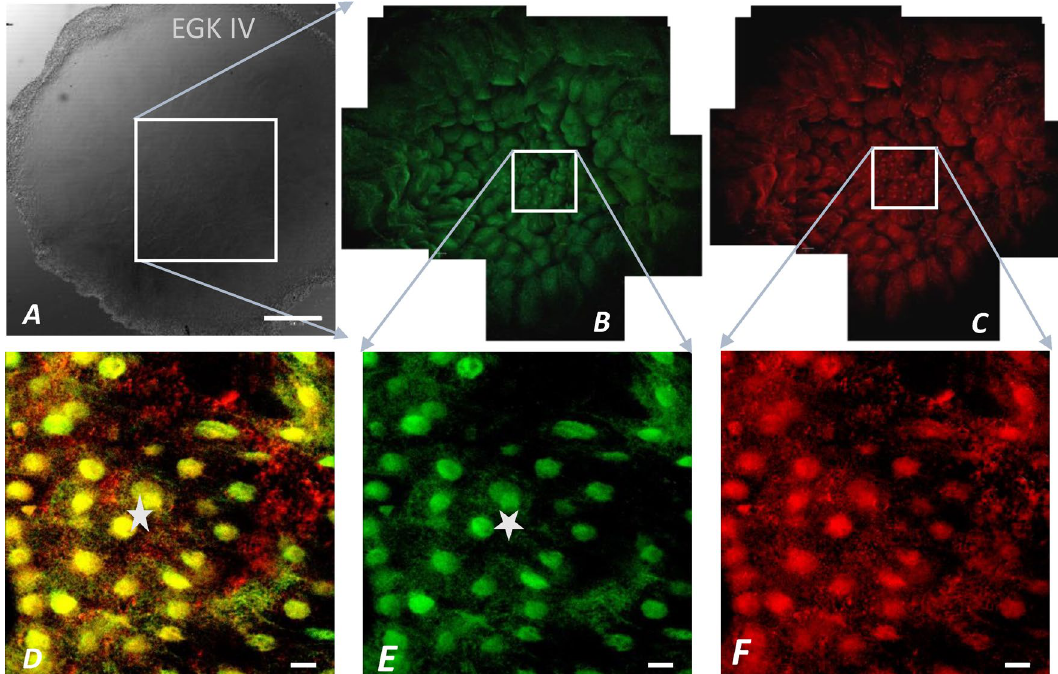
Figure 8. Co-localized Bucky ball and CVH expression in stage EGK IV. This composition of eight stitched images visualizes in the magnified center of a stage EGK IV embryo (frame of the overview in ( A ) the concentrated nuclear localization of Bucky ball ( B ) and CVH ( C ) within the central cells of the germinal disc surrounded by cells with cytoplasmic germ plasm of Bucky ball and CVH. In ( D ) the overlay with clear co-localization of Bucky ball ( E ) and CVH ( F ) in cells of the nuclear region of EGK IV embryos is shown. Numbers with nuclear region labels exceed 20 cells repeatedly. Scale in ( A ): 500 µm, scales ( D–F ): 20 µm.